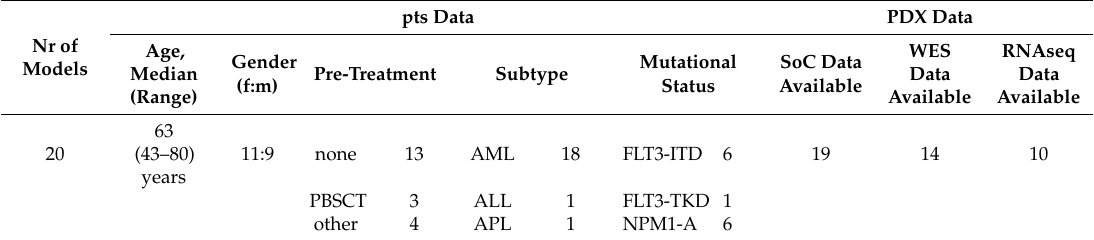
Table 1. Characteristics of the leukaemia patient-derived xenografts (PDX)